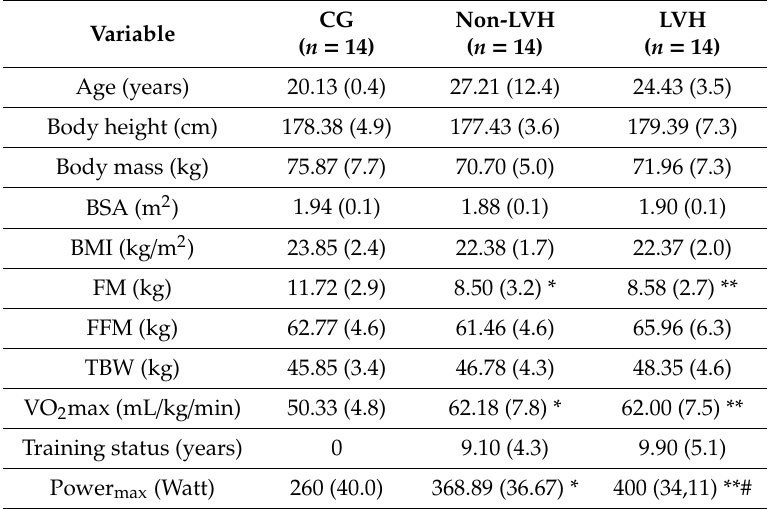
Table 1. Characteristics of study participants: athletes with left ventricle hypertrophy (LVH), athletes without left ventricle hypertrophy (non-LVH), and untrained control group (CG). CG Non-LVH Variable ( n = 14) ( n =